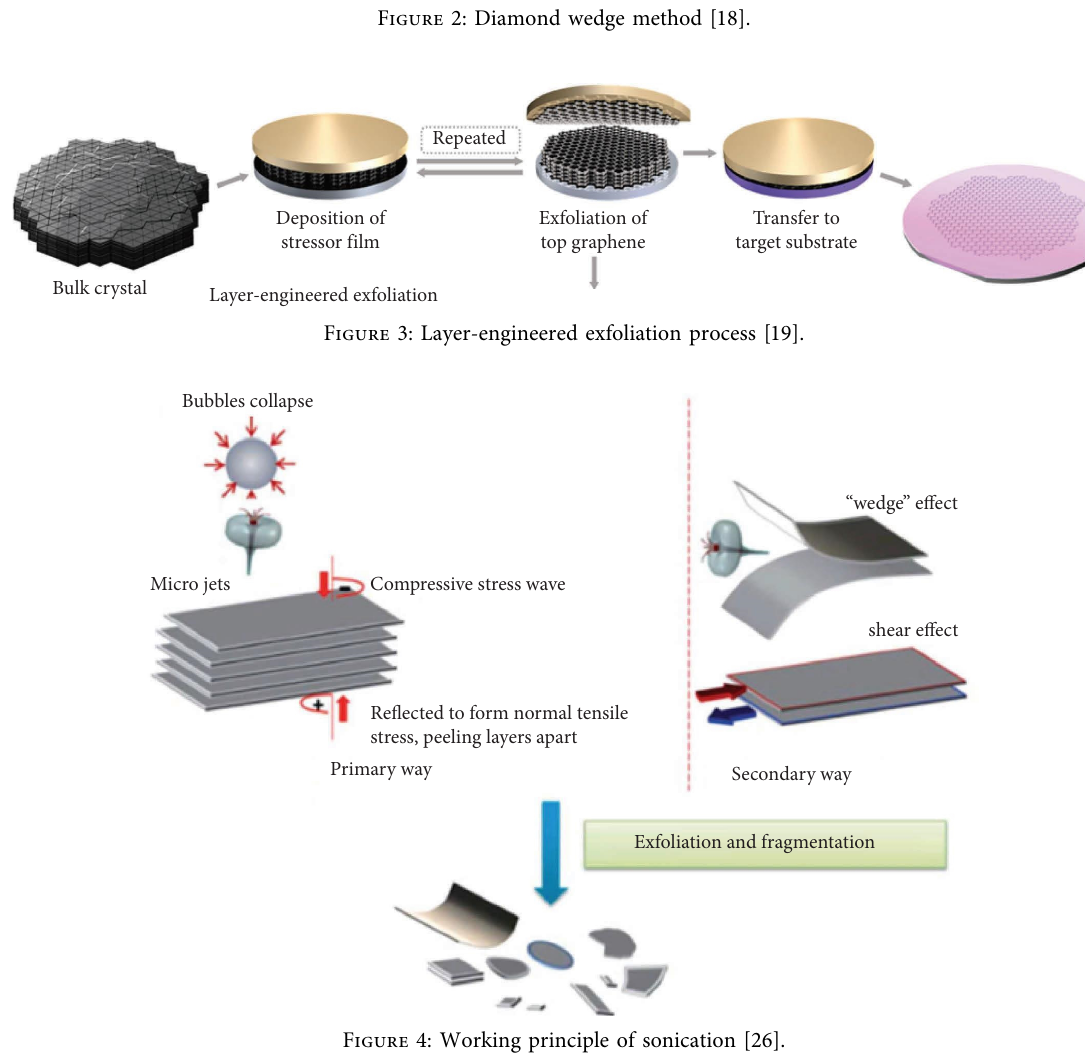
Figure 2: Diamond wedge method [18].